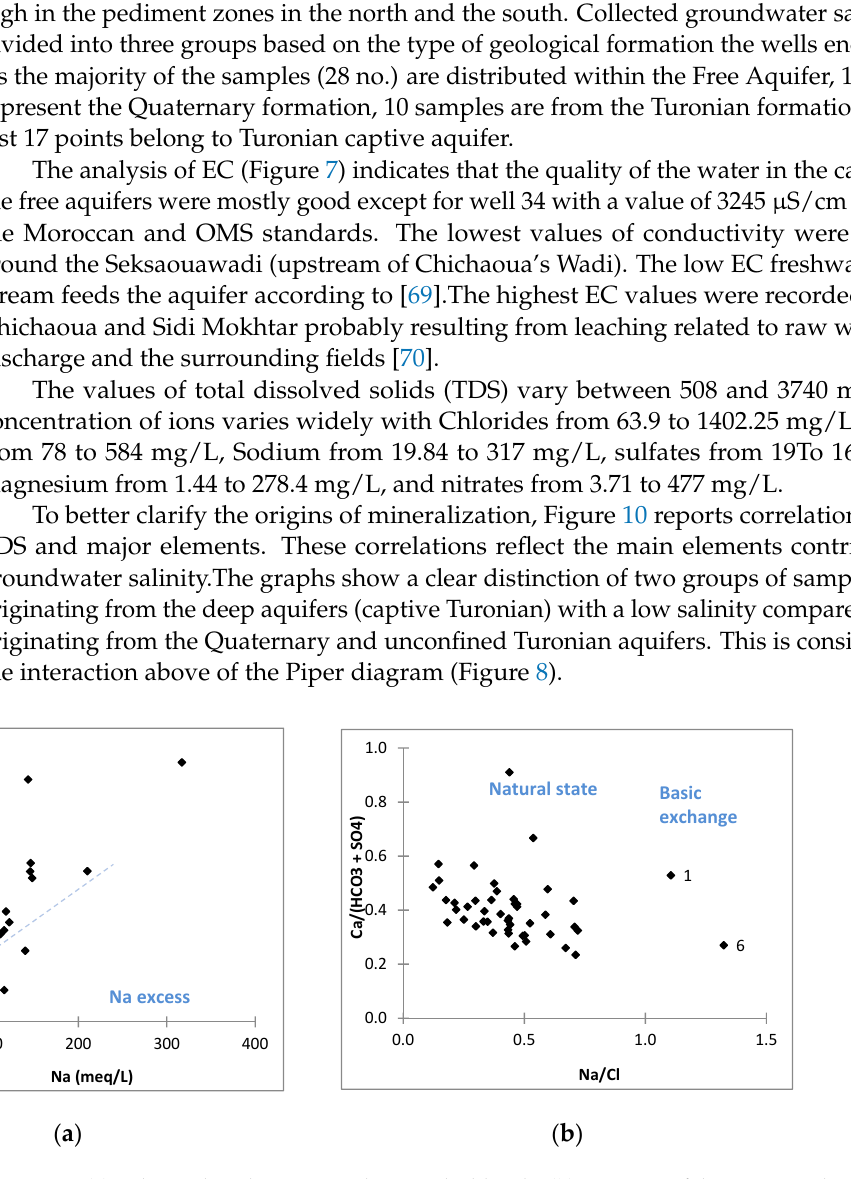
Figure 10. ( a ) Relationships between Sodium and Chloride; ( b ) Diagram of the cation exchange process.